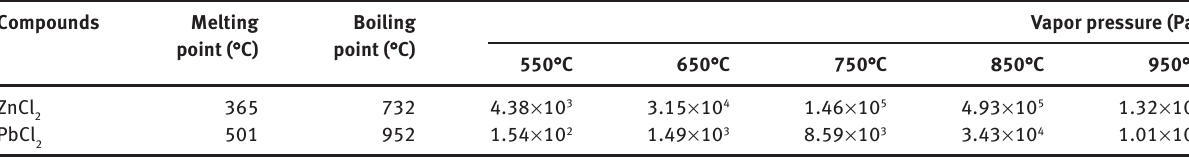
Table 3: The melting point, boiling point and vapor pressure of zinc oxide dust [32].